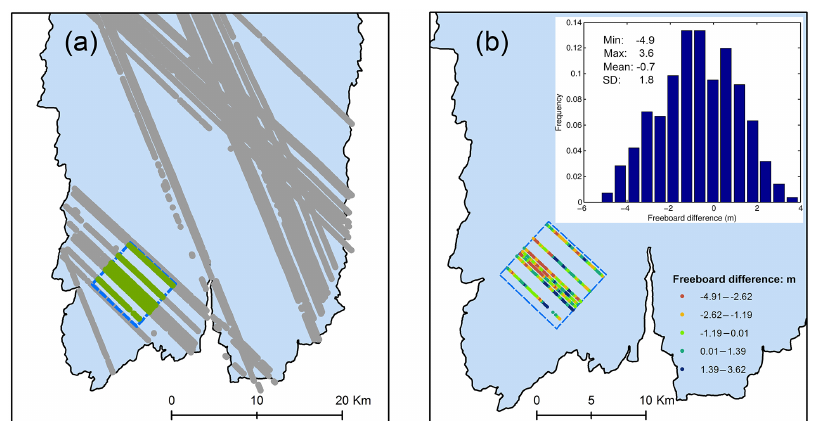
Figure 5. Evaluation of kriging interpolation method over the MIT using freeboard data derived from the ICESat/GLAS data. (a) shows profile location of freeboard derived from the ICESat/GLAS data after relocation over the MIT. The gray dots indicate the ICESat/GLAS data used for interpolation using kriging method. The blue dashed square indicates the 7km × 7km region used to investigate the accuracy of kriging interpolation method. Inside the square, the freeboard data marked with green dots are used to check the accuracy of the freeboard interpolated with kriging. (b) is the freeboard comparison result derived by subtracting the krigged freeboard from the freeboard derived from the ICESat/GLAS. The spatial distribution and the histogram of the freeboard difference are shown in the lower left and upper right, respectively. The black polygon filled with light blue shows the boundary of the MIT on 14 November